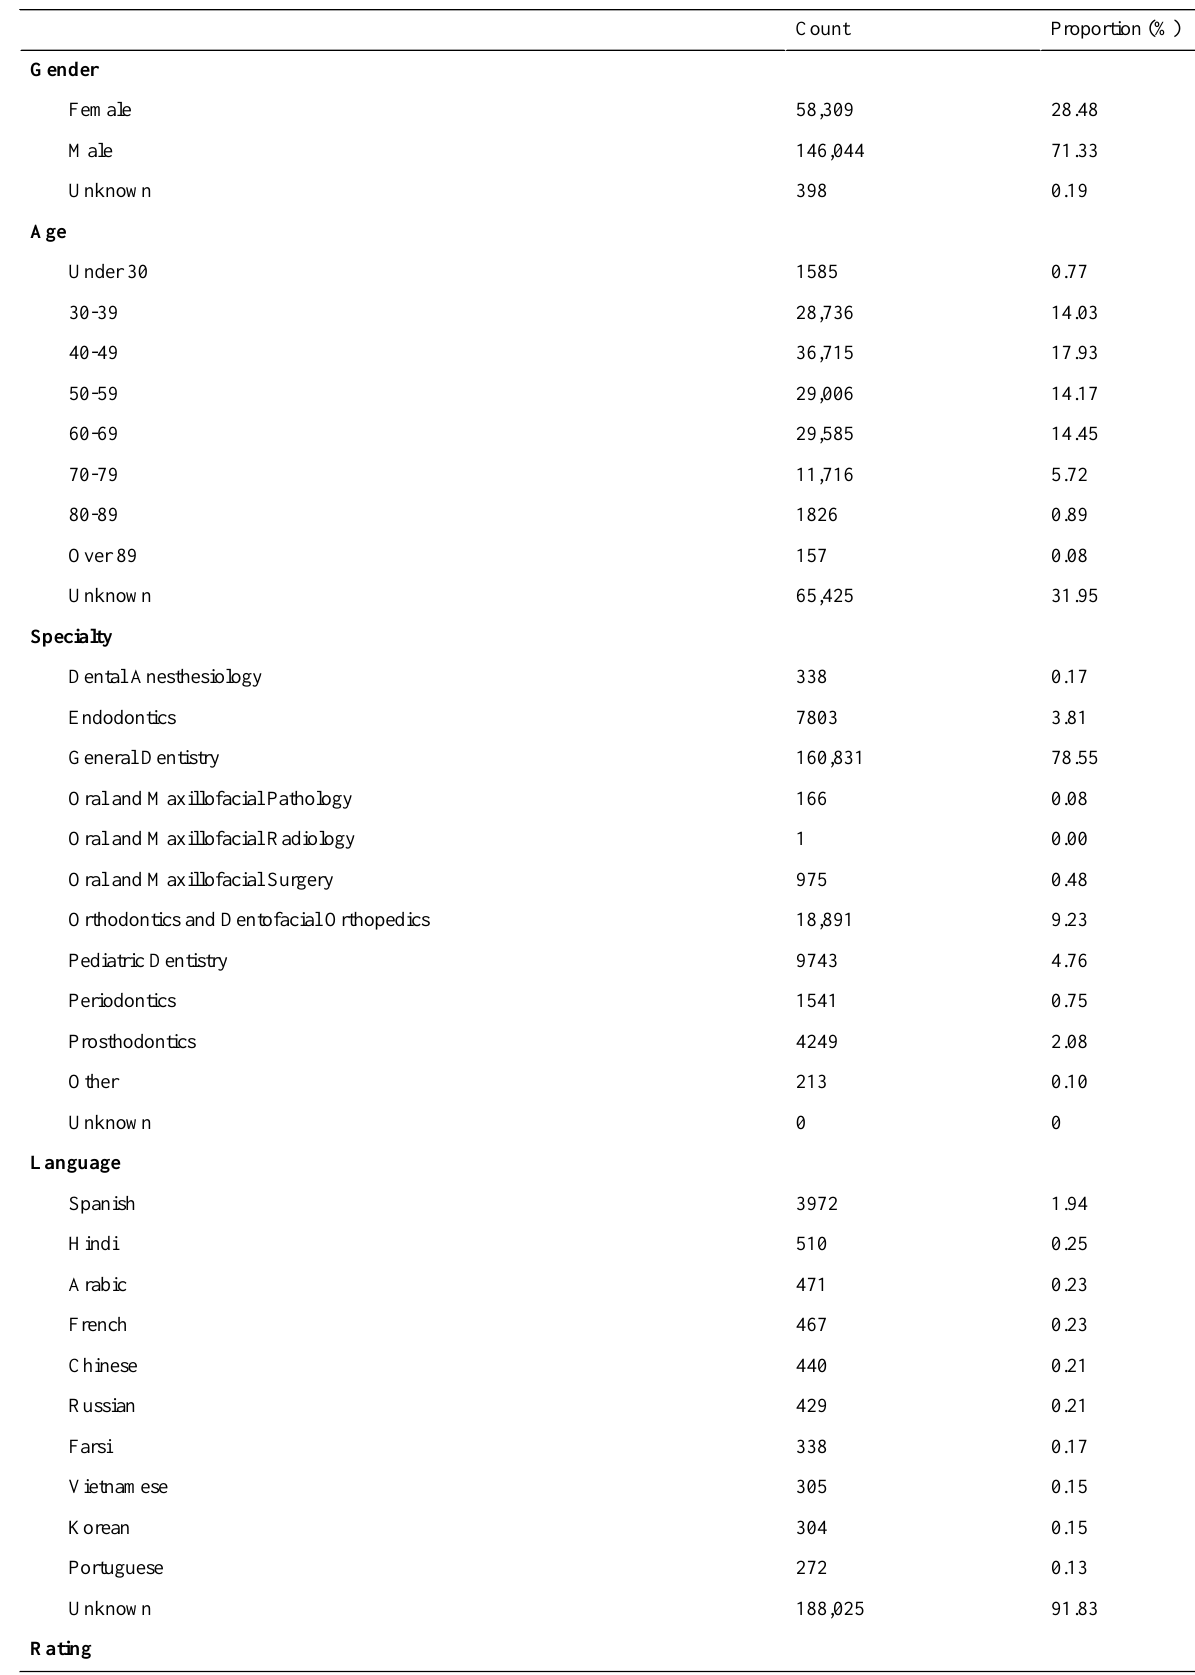
Table 2. Dentist